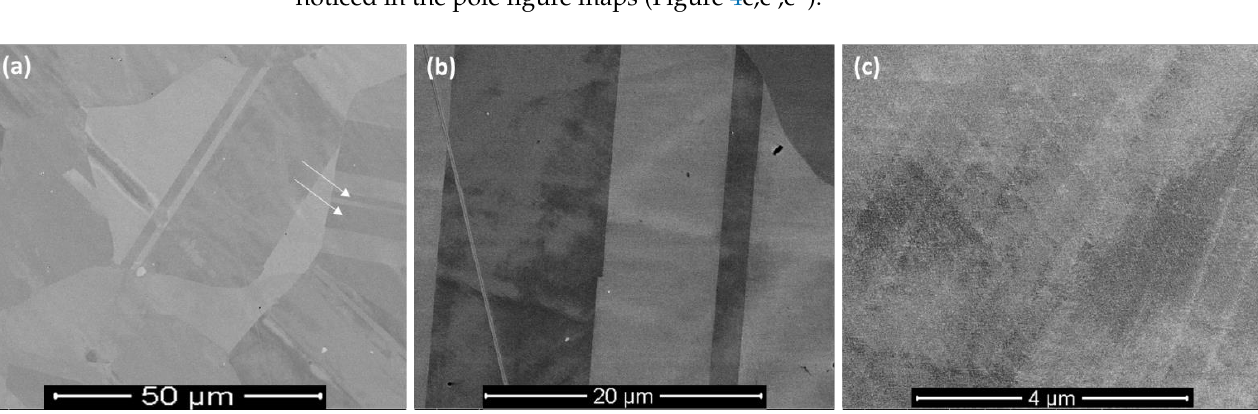
Figure 5. EBSD maps on cast Inconel 718 alloy: ( a ) Grain boundary (GB), ( b ) inverse pole figure (IPF), and ( c ) pole figure (PF) maps. In addition to the texture evaluation, grain size distribution was also obtained from the EBSD investigation, as shown in Figure 6. From Figure 6, it was clear that the average grain size of L-PBF-processed alloy was about 1.4–1.7 µm, which was a couple of a mag- nitude larger than the cell size (Figure 4b’). In contrast, the grain size of the cast alloy was about 3.4 ± 0.2 µm.